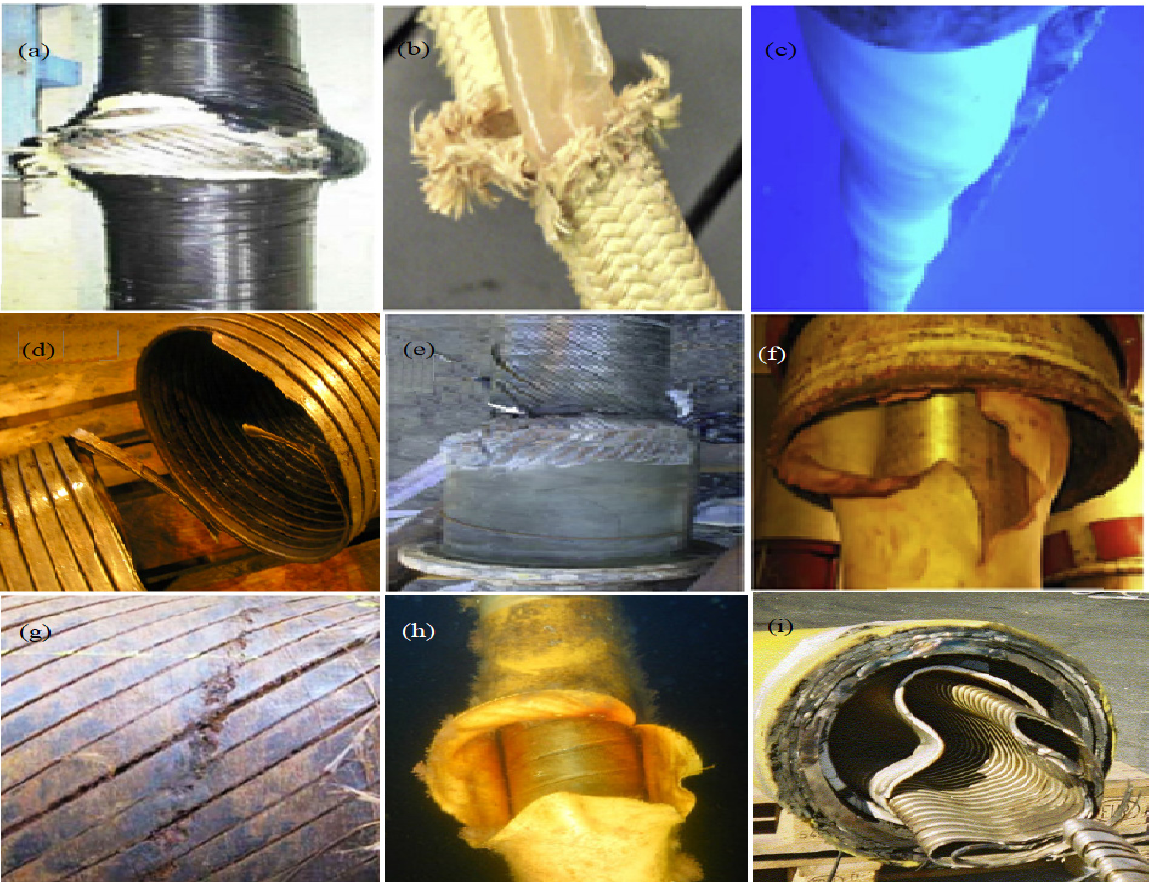
Figure 31. Image collage of unbonded flexible pipeline failure types observed showing failure modes of flexible risers: ( a ) bird caging; ( b ) aramid hose layer rupture from burst showing crease region ( c ) torsion at riser top due to ruptured armour wires; ( d ) carcass damage; ( e ) tensile armour wire rupture due to fatigue; ( f ) rupture of external sheath from blocked vent tubes; ( g ) armour wire corrosion; ( h ) burst external sheath from blocked vents; and ( i ) carcass collapse(Sources: [36–41]).